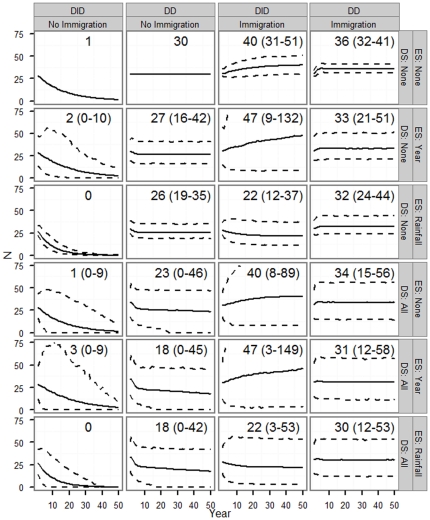
Population sizes by simulation scenario.Projected mean population size (solid lines) and 90th percentile (dashed lines) of projected population sizes based on 10,000 simulations across 24 scenarios depending on whether and how density dependence, immigration, demographic stochasticity, and environmental stochasticity were modeled. Mean projected population size and 90th percentiles in year 50 (rounded to the nearest integer) also are given for each scenario within the figure panels. See Figure 4 for the description of scenarios and other simulation details.